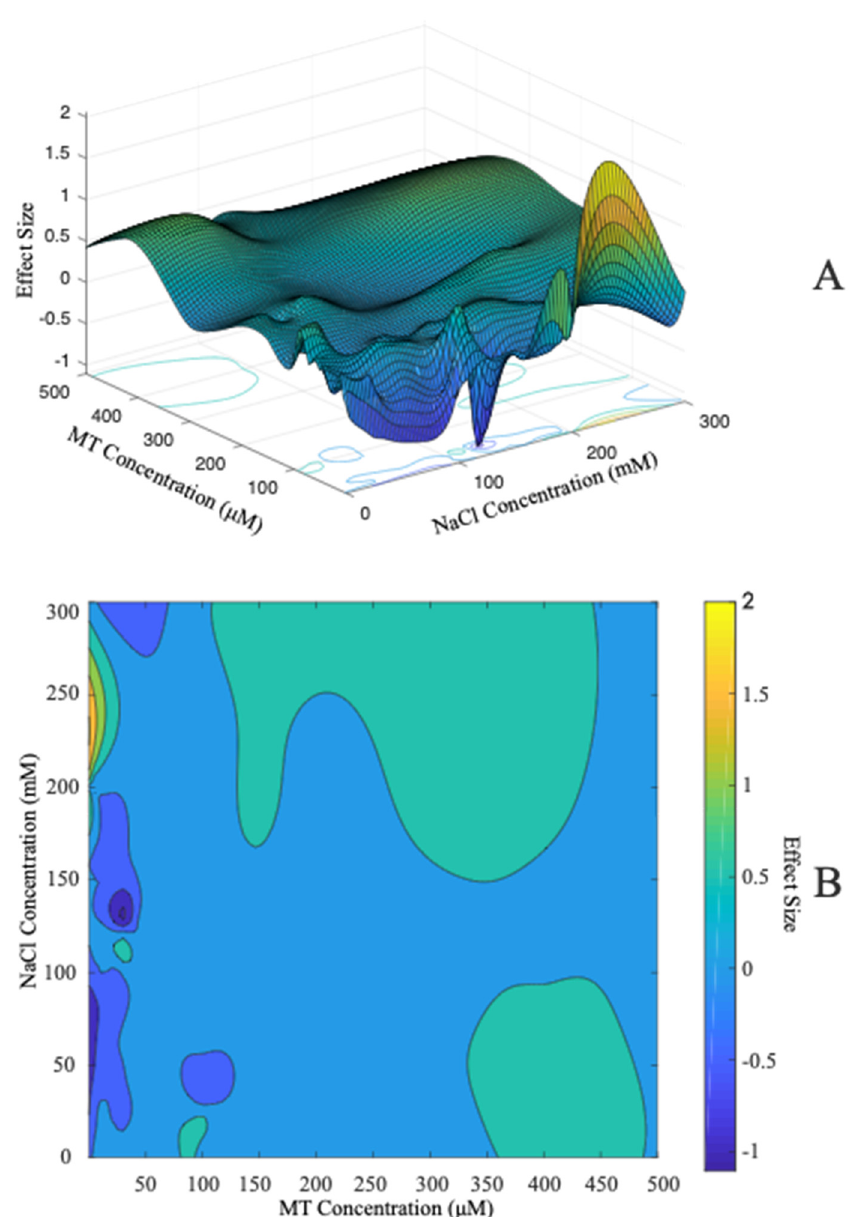
Figure 2. Effects of MT and salt stress on plant growth. ( A ) shows the surface without fitting, and ( B ) shows the contour map of ( A ). We also carried out quintic equation fitting on the data, and the fitted equation and surface diagram are shown in Figure A3.